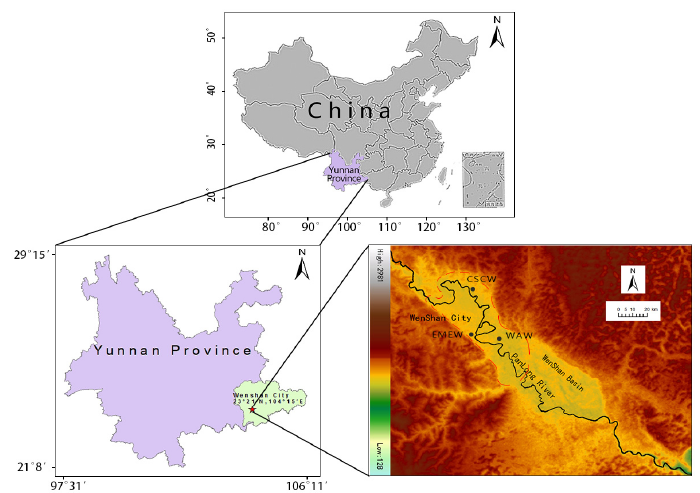
Figure 1. Location of the sampling site in Wenshan, China. Measurement campaigns of PM 2.5 sampling at three sites at the Convenience Service Center of Wenshan (CSCW), Water Authority of Wenshan (WAW) and